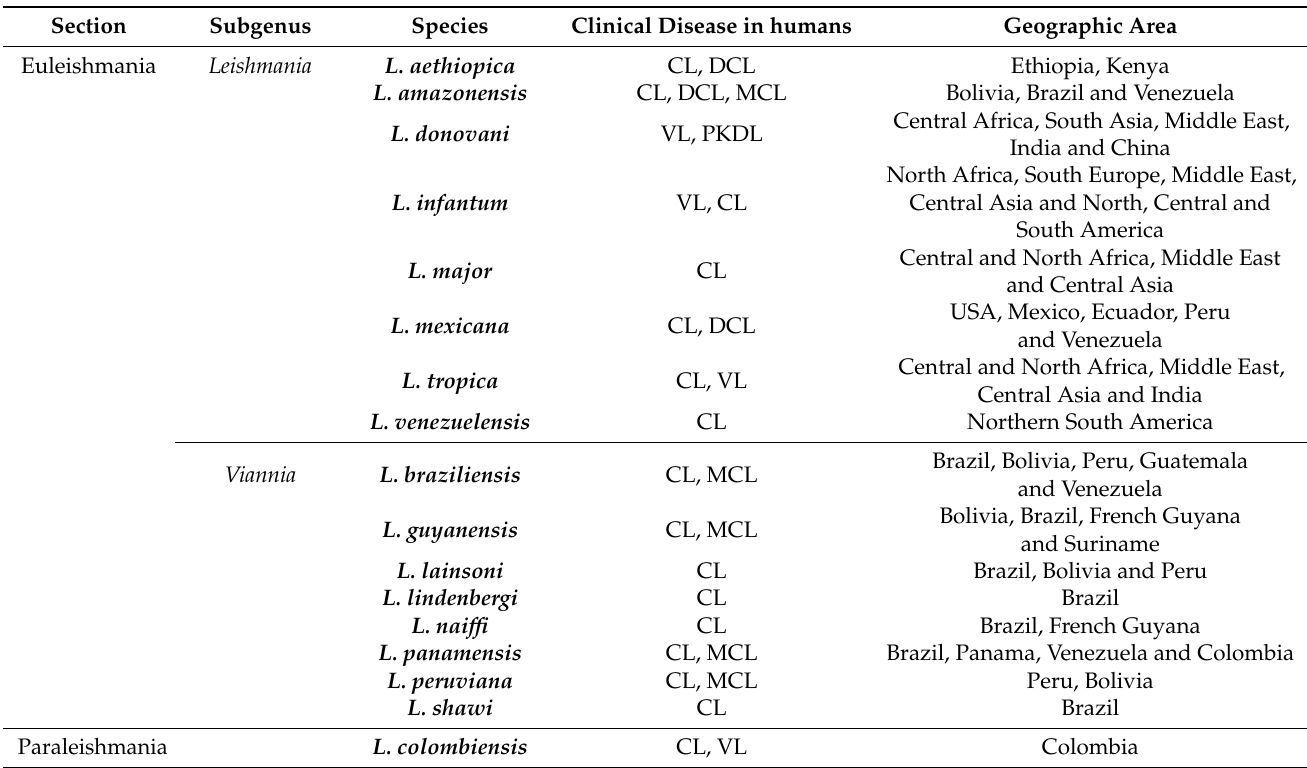
Table 1. Zoonotic species of the genus Leishmania and their main characteristics (adapted from Ahoundi et al., 2016 and 2017